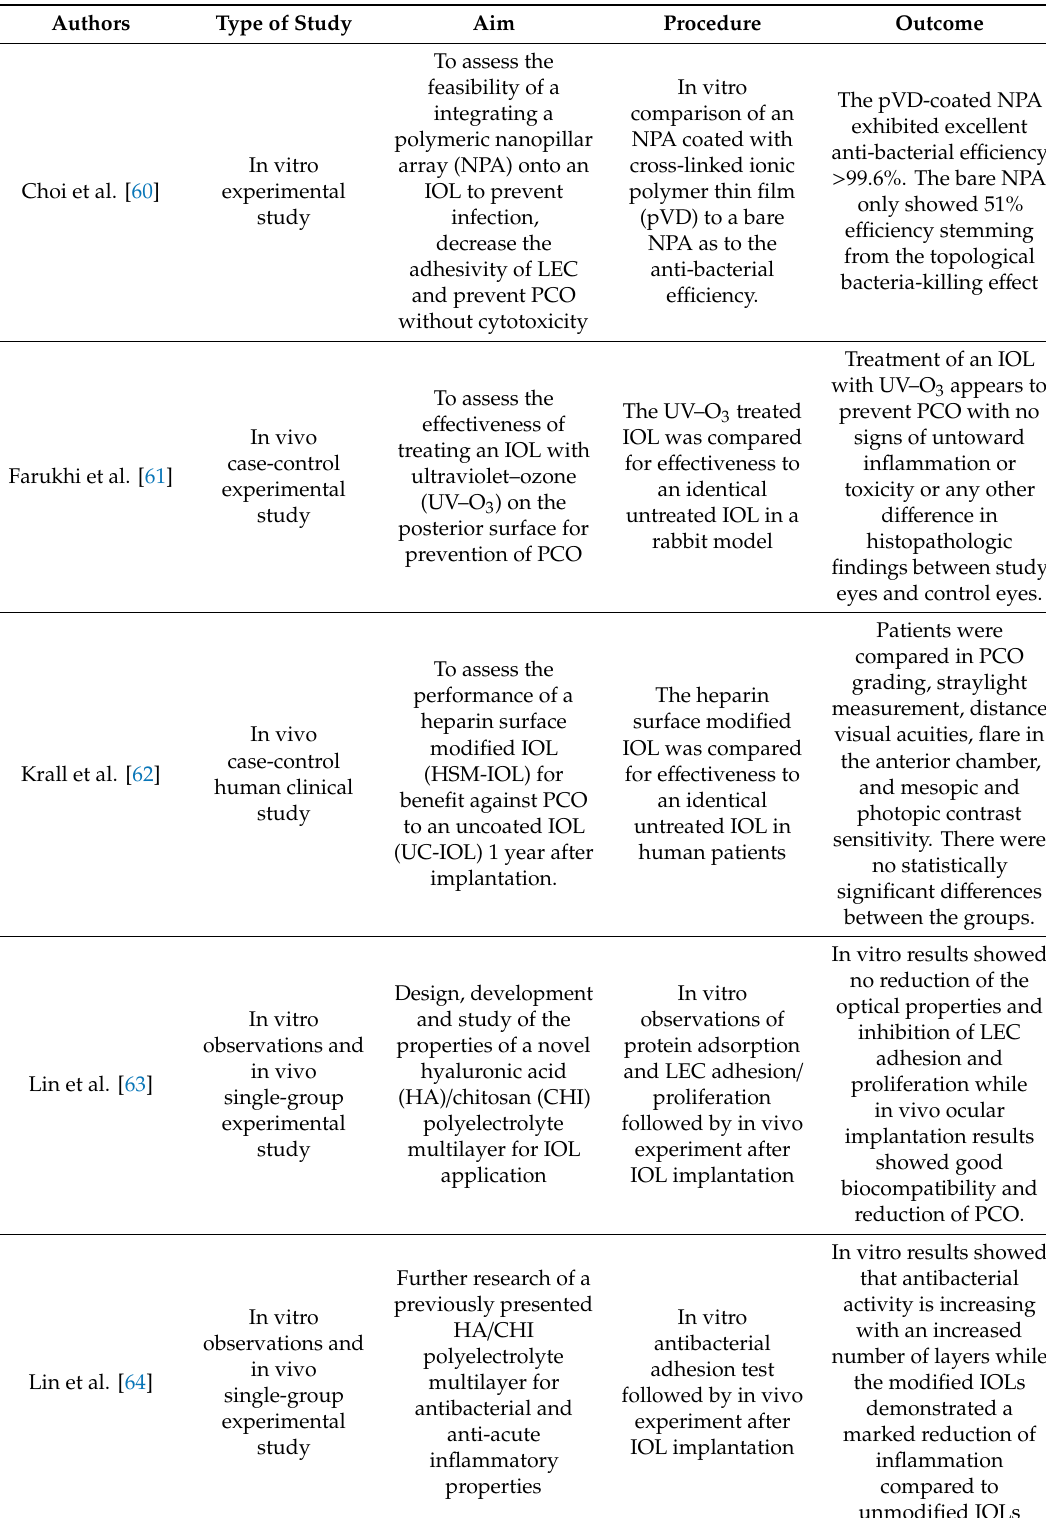
Table 3. Included studies examining non-pharmaceutical IOL surface modifications over the past five